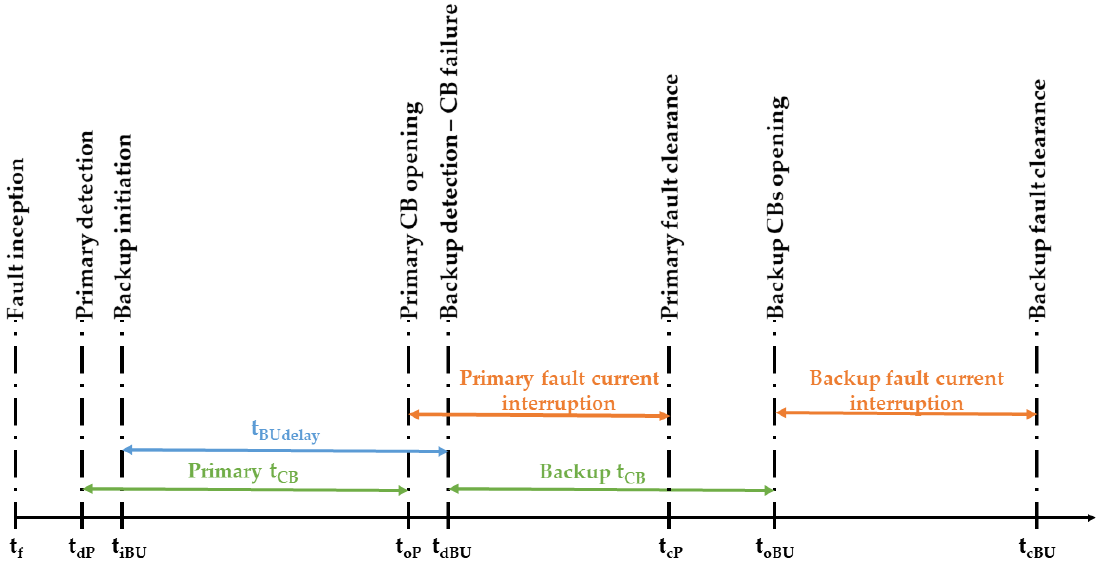
Figure 4. Time diagram of the proposed backup protection.